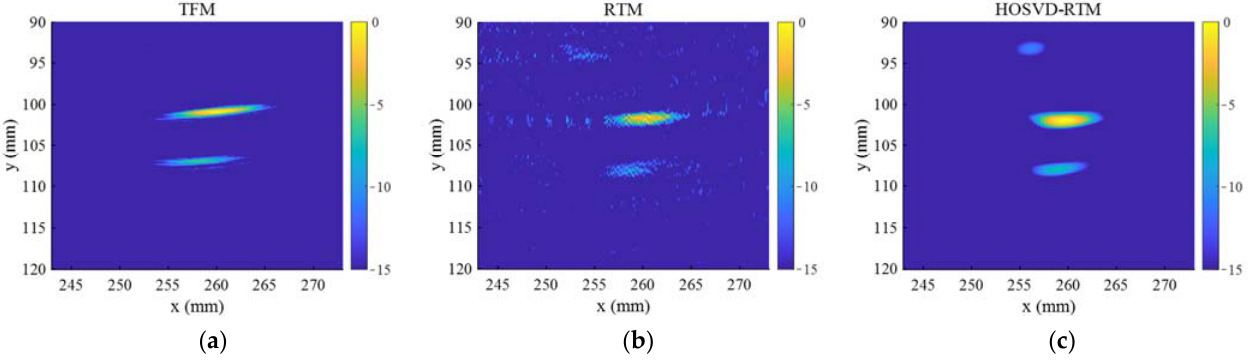
Figure 15. Imaging results obtained with the array composed of 8 elements and 3 algorithms: ( a ) TFM, ( b ) RTM, and ( c ) HOSVD-RTM.